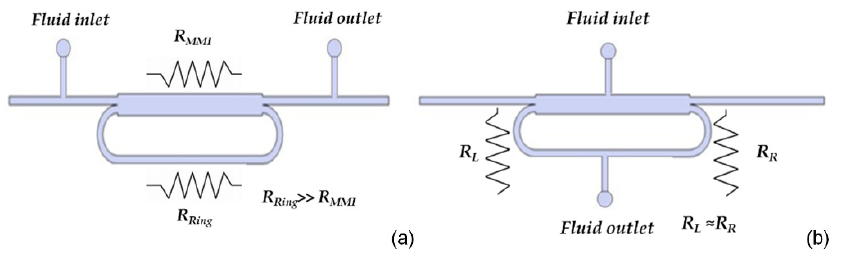
Figure 2. Possible schemes for microfluidic integration. ( a ) Unbalanced and ( b ) balanced fluidic re- sistances.